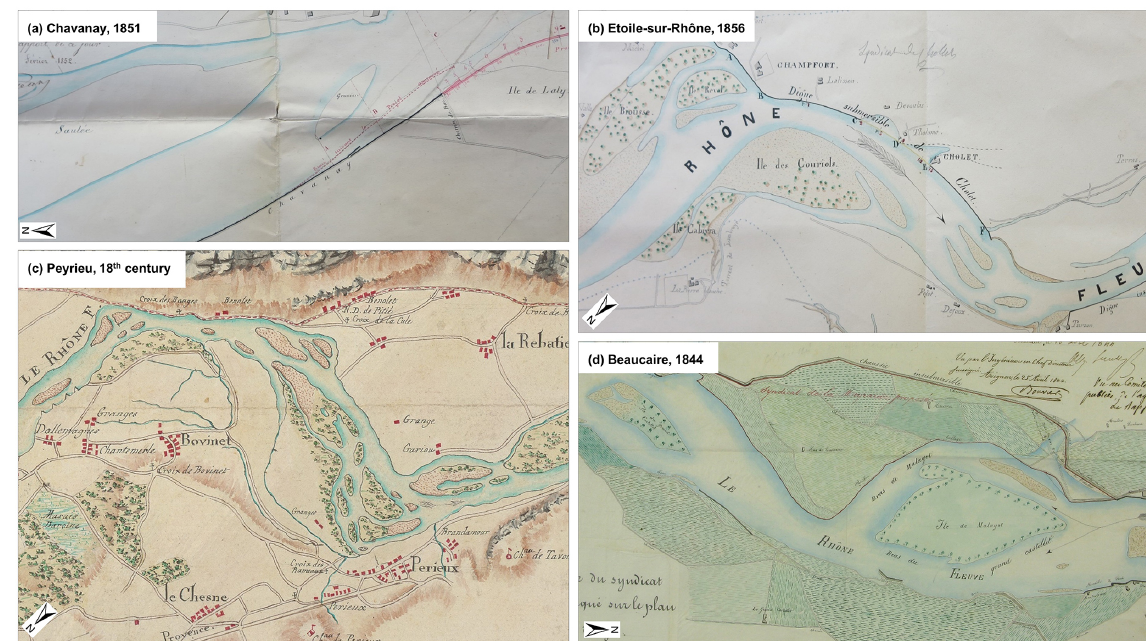
Figure 11. Examples of vegetation representation from the simplest to the most detailed: (a) island annotation: “saulée” in French means “willows”, “gravier” means “gravel” (source: Goux, 1851, AD Rhône, S 1393); (b) riparian vegetation close to the channel (source: Kleitz, 1856, AD Rhône, S 1397); (c) depiction of vegetation in the floodplain (source: unknown author, 18th century, National Archives, CP/F14/10074/1/A/Piece3); (d) differentiation between vegetation types (source: Bouvier, 1844, National Archives, F/14/6583).